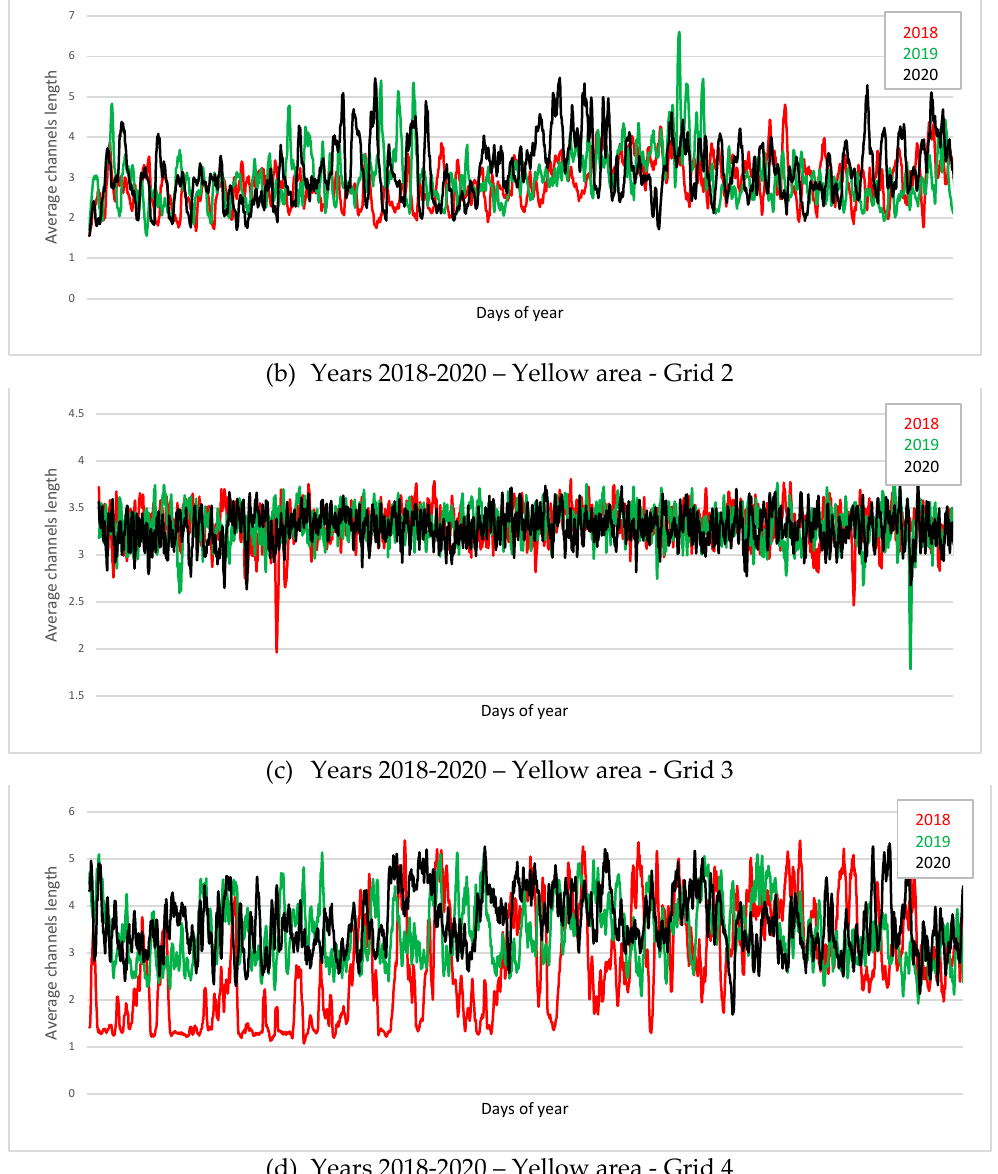
Figure 15. Results corresponding to the average length of channels constituted from 2018 to 2020 in the yellow geographical area under study.